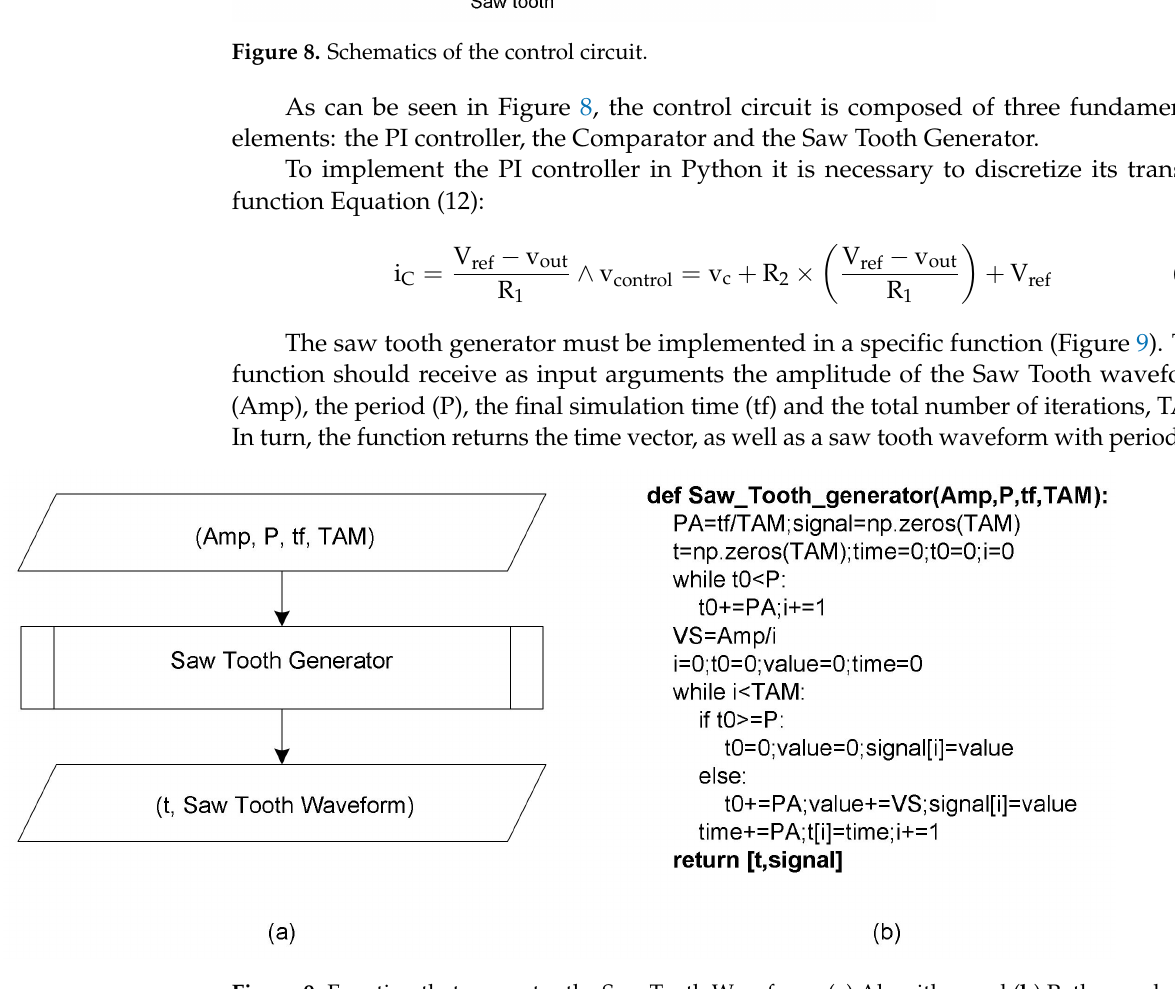
Figure 9. Function that generates the Saw Tooth Waveform: ( a ) Algorithm and ( b ) Python